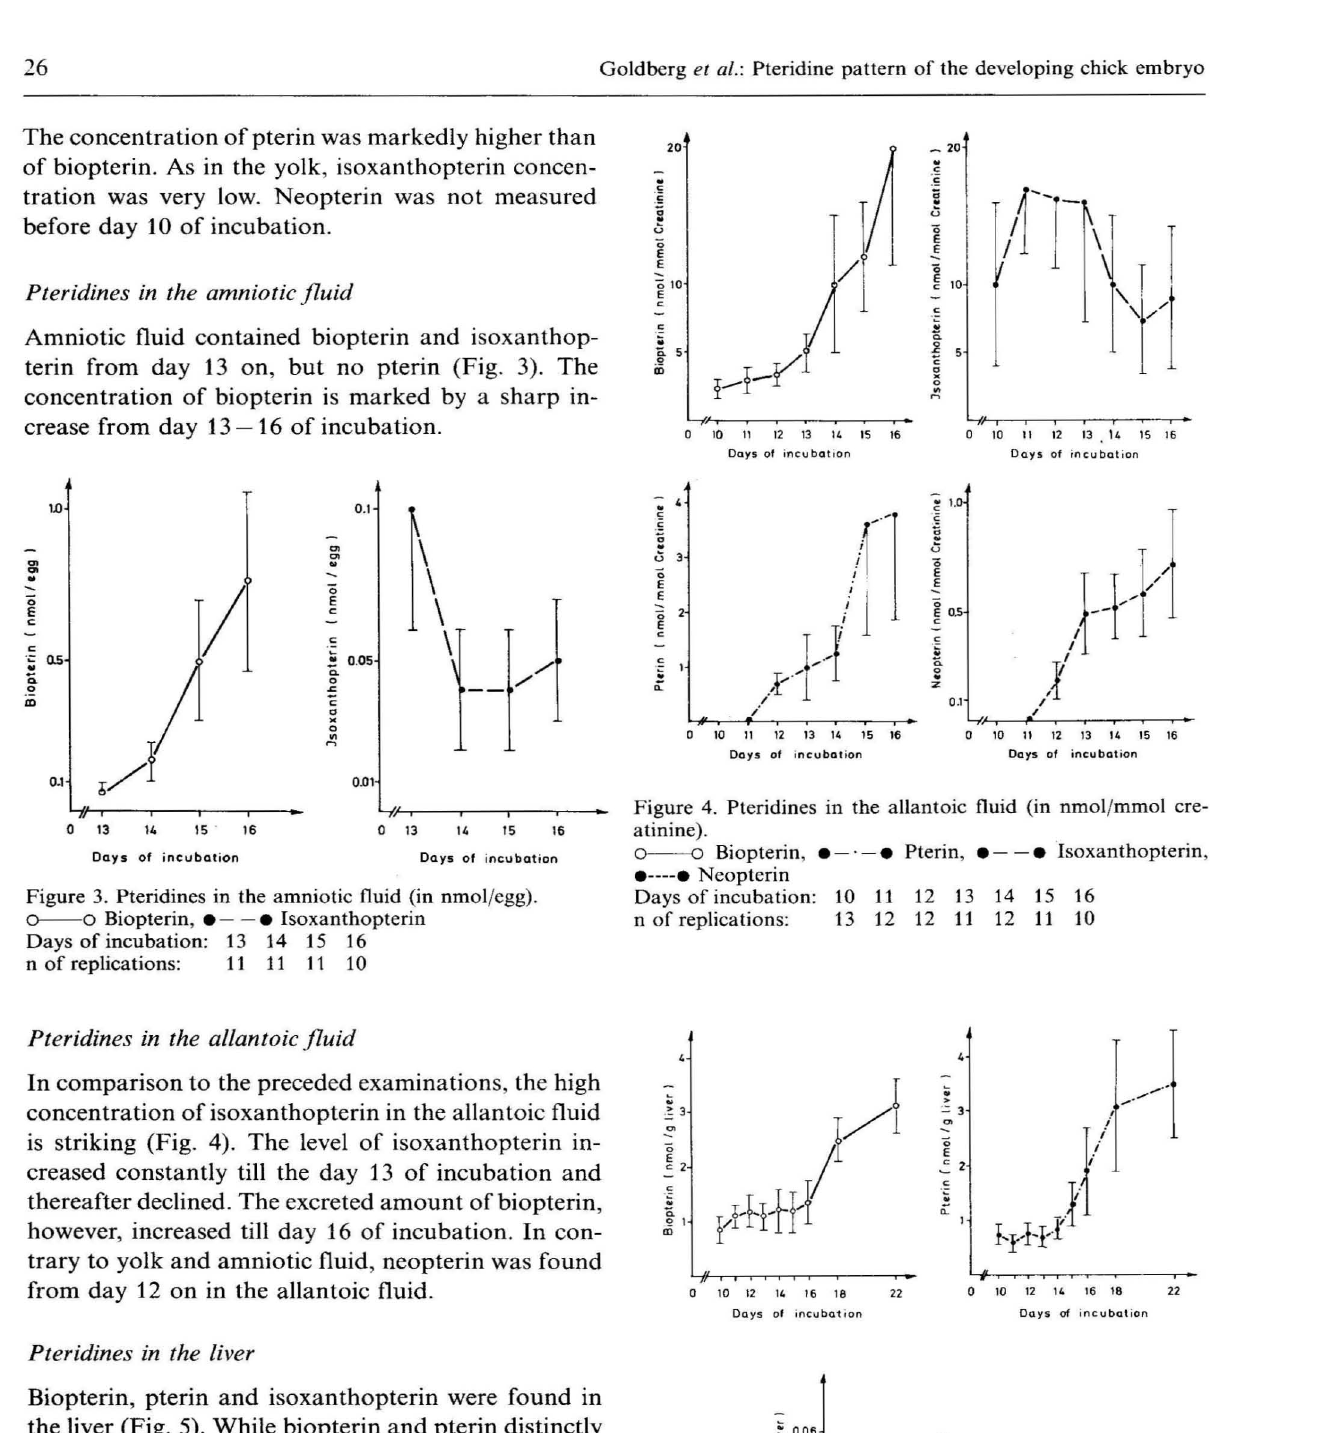
Figure 3. Pteridines in the amniotic fluid (in nmoljegg). 0-0 Biopterin, • - -. Isoxanthopterin Days of incubation: 13 14 15 16 n of replications: 11 11 11 10